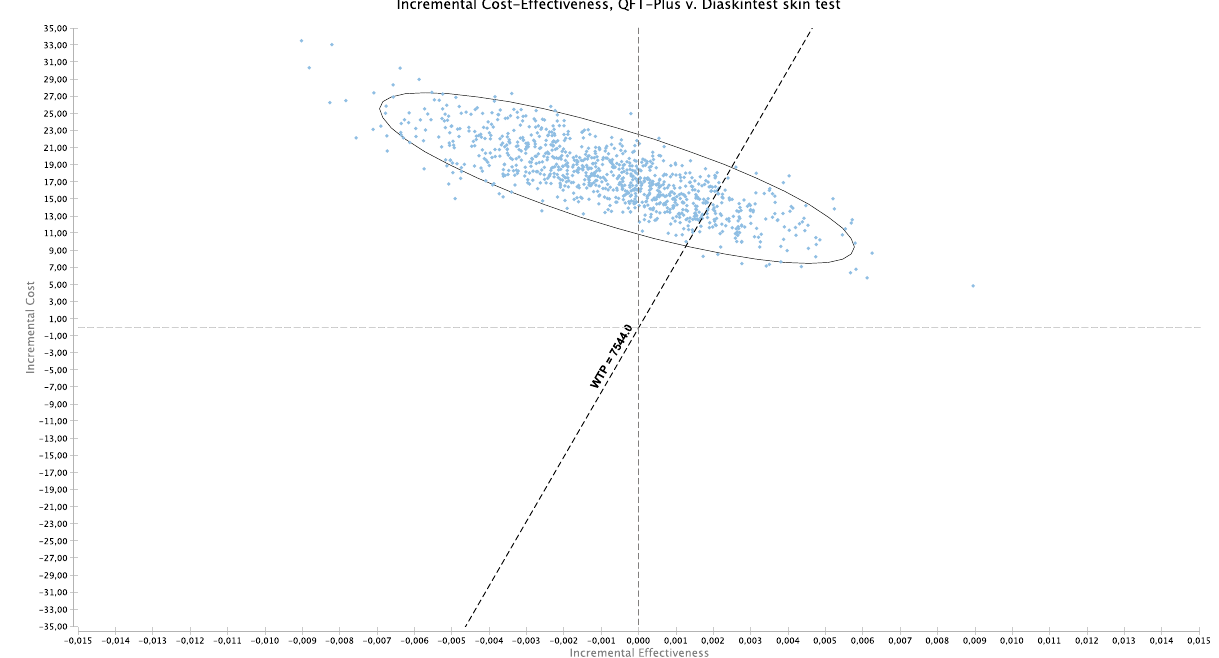
Figure 4. Scatter plot of QFT-Plus versus Diaskintest incremental cost-effectiveness ratio (ICER) in costs (in 2020 US dollars [US$]) per quality-adjusted life years (QALYs). This scatter plot shows 10,000 Monte Carlo iterations results of ICER of QFT-Plus versus Diaskintest. The diagonal line represents the willingness to pay threshold of US $7544. The elliptical line represents the 95% confidence interval. Values on the left upper quadrant are dominated. Values on the right upper quadrant are most costly and more effective. Values to the left of the diagonal line are above the willingness to pay threshold value. QFT-Plus QuantiFERON TB Gold